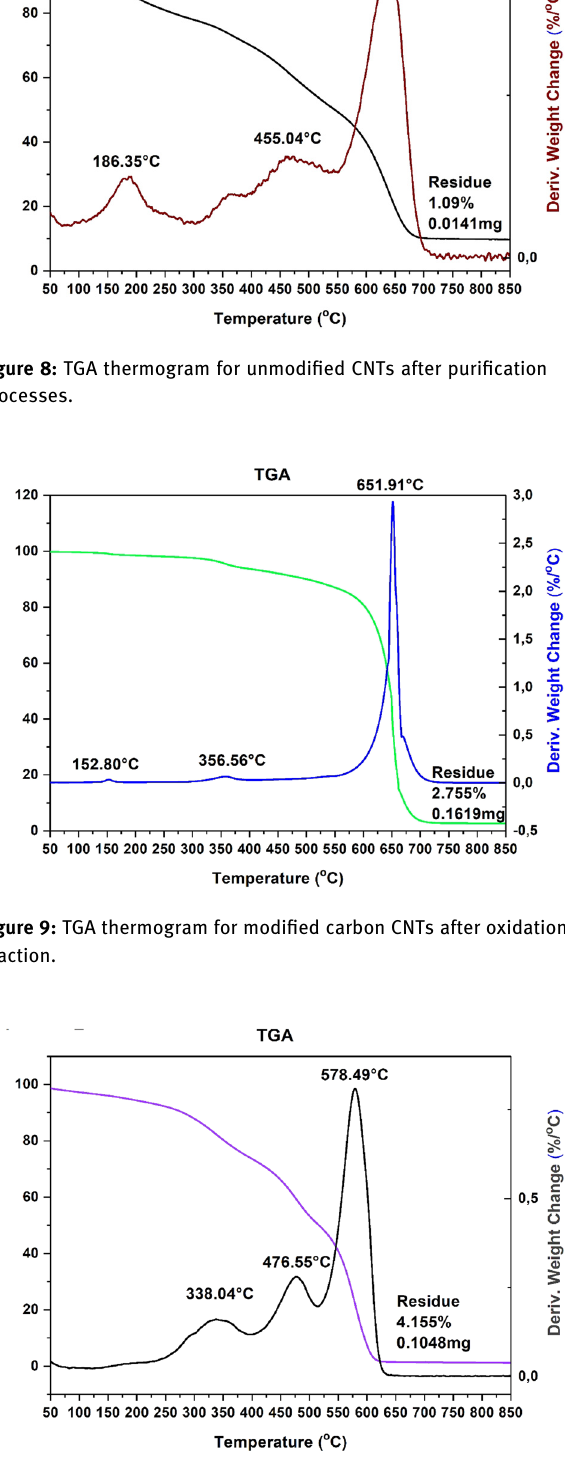
Figure 10: TGA thermogram for modi fi ed CNTs after acylation with 4 -( 1 - pyrinyl )- butanoic acid.